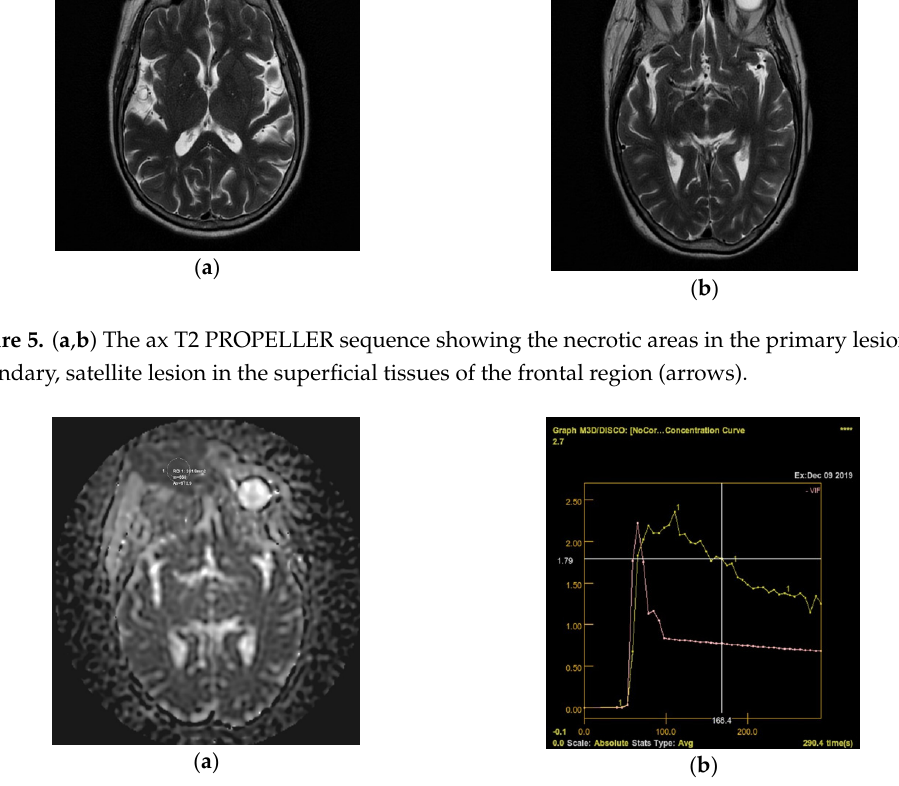
Figure 6. ( a ) Restricted diffusion on DWI sequences was observed, with an ADC value of 0.873 × 10 − 3 mm 2 /s on the ADC map; ( b ) Dynamic contrast-enhanced MRI (DCE-MRI) imaging showed a type III (C) curve highly suggestive for malignancy. Diagnostics 2020 , 10 , x FOR PEER REVIEW